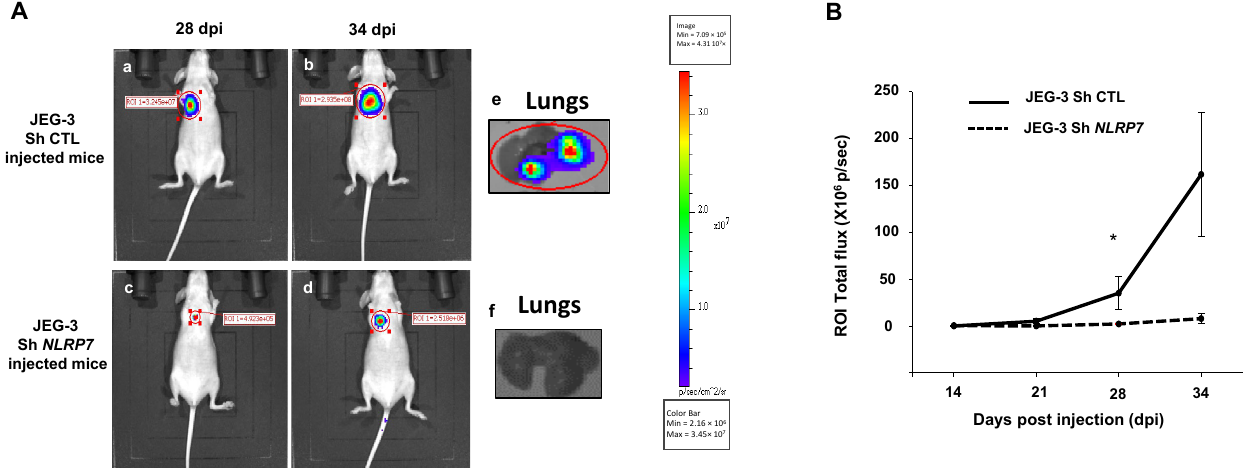
Figure 6. Comparison of tumor growth in mice injected with JEG-3 Sh CTL or JEG-3 Sh NLRP7 in the tail vein. ( A ) shows representative images of female mice injected with JEG-3 Sh CTL ( Aa , b ) n = 7 or JEG-3 Sh NLRP7 ( Ac , d ) n = 7 at day 28 and 34 post injections (DPI), respectively. Photographs in ( Ae , f ) show representative images of lungs collected from JEG-3 Sh CTL or JEG-3 Sh NLRP7 injected mice, respectively. ( B ) compares tumor lung growth in JEG-3 Sh CTL and in JEG-3 Sh NLRP7 from 14 to 34 DPI; * p <